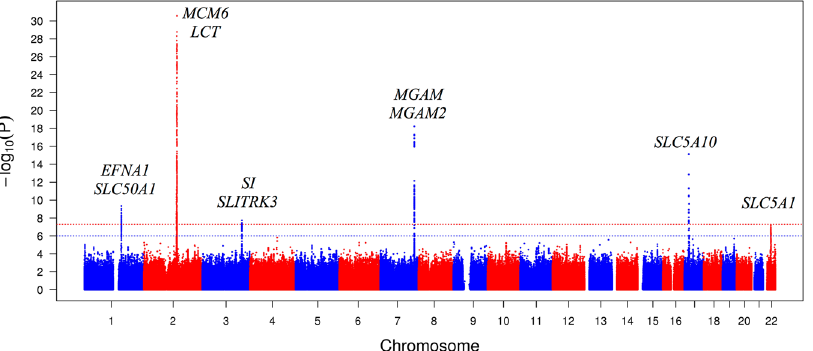
Figure 1. Manhattan plot of the results of the GWAS of 1,5-anhydroglucitol in European American participants from the ARIC study. The y-axis represents the ( − log 10 ) association P-values and the x-axis the genomic position (GRCh build37). The red dotted line indicates the threshold for genome-wide significance ( P < 5 × 10 − 8 ) and the blue dotted line the suggestive significance threshold ( P < 1 × 10 − 6 ). For intergenic index variants, the flanking genes are provided as annotation.